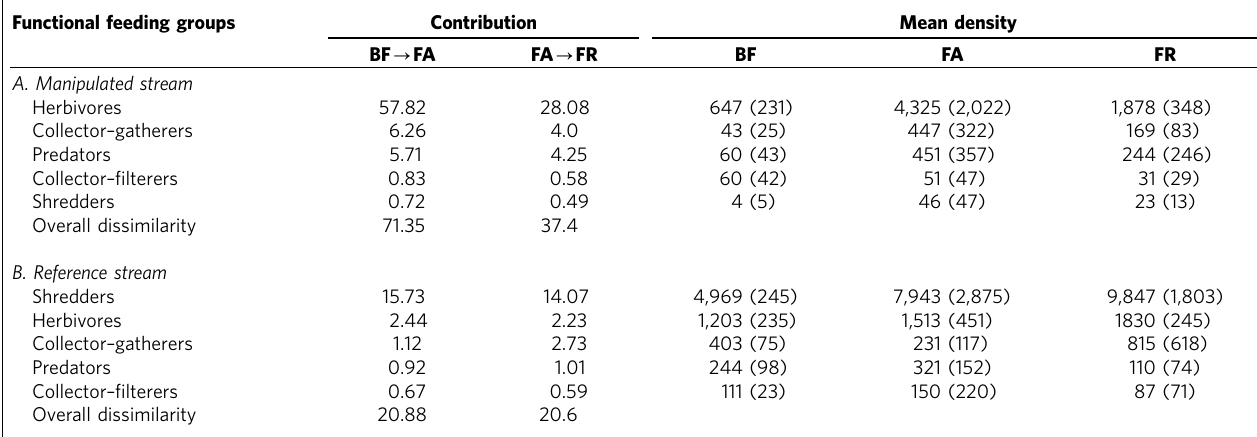
Table 1 | Dissimilarity in feeding trait composition. Functional feeding groups